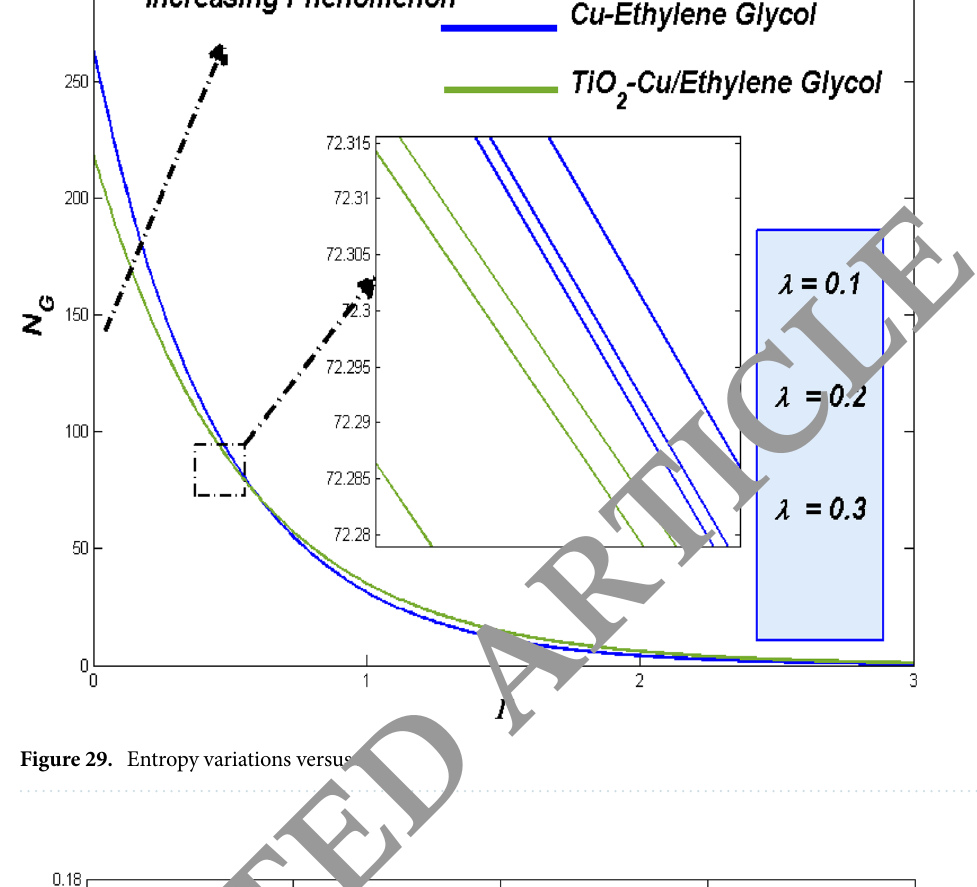
Figure 29. Entropy variations versus (cid:31) .